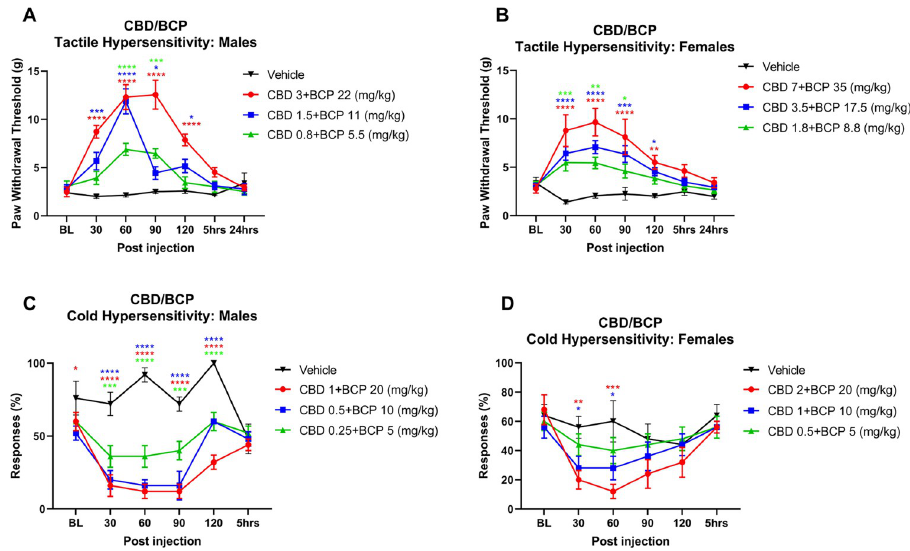
Fig 5. Time course of CBD and BCP in combination on SCI pain responses in males and female rats. Time plots of the effect of (A) CBD plus BCP on mechanical PWT in males; (B) CBD plus BCP on PWT in females; (C) CBD plus BCP on acetone responses in males; (D) CBD plus BCP on acetone responses in females (n = 5 per treatment group). All doses and dose ratios were determined from previous individual dose-response analysis as described in the text. � , �� , ��� , ���� denote p < 0.05, 0.01, 0.001 and 0.0001 compared to vehicle for each treatment